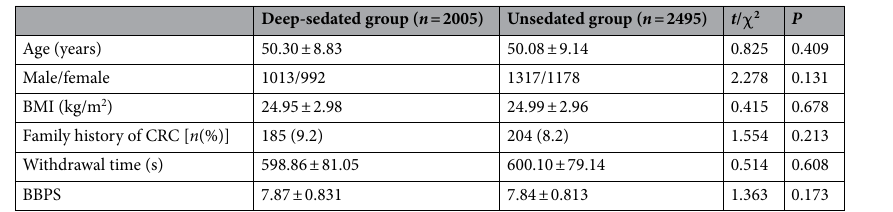
Table 1. Comparison of baseline characteristics between deep-sedated group and unsedated group. BMI body mass index, CRC colorectal cancer, BBPS boston bowel preparation scale.